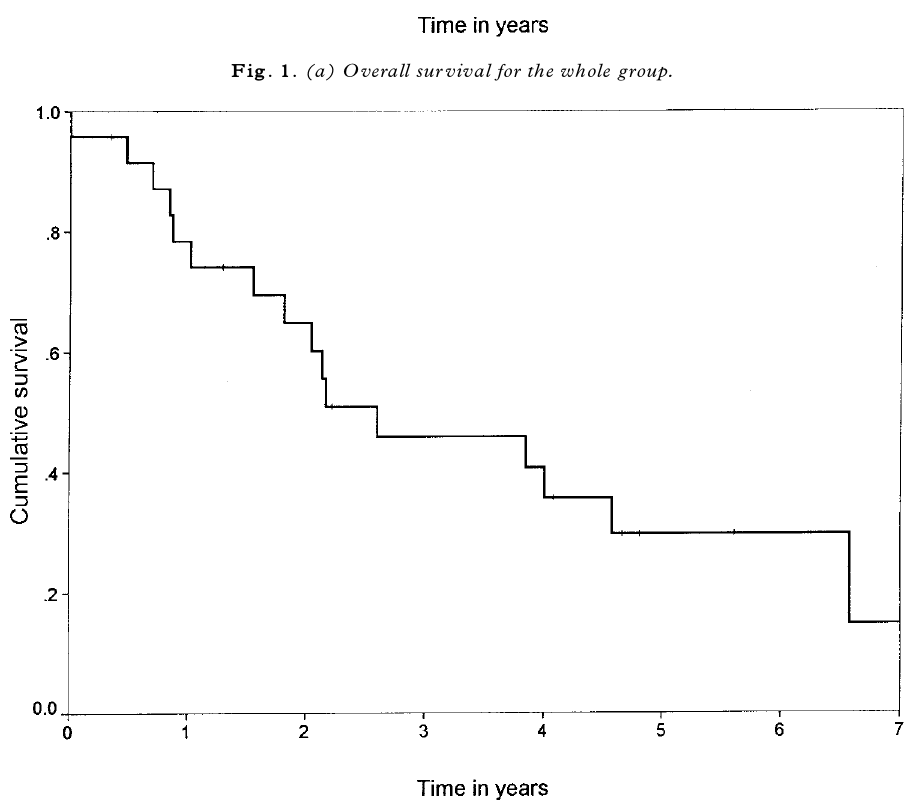
Fig. 1. (b) Disease-free survival for the whole